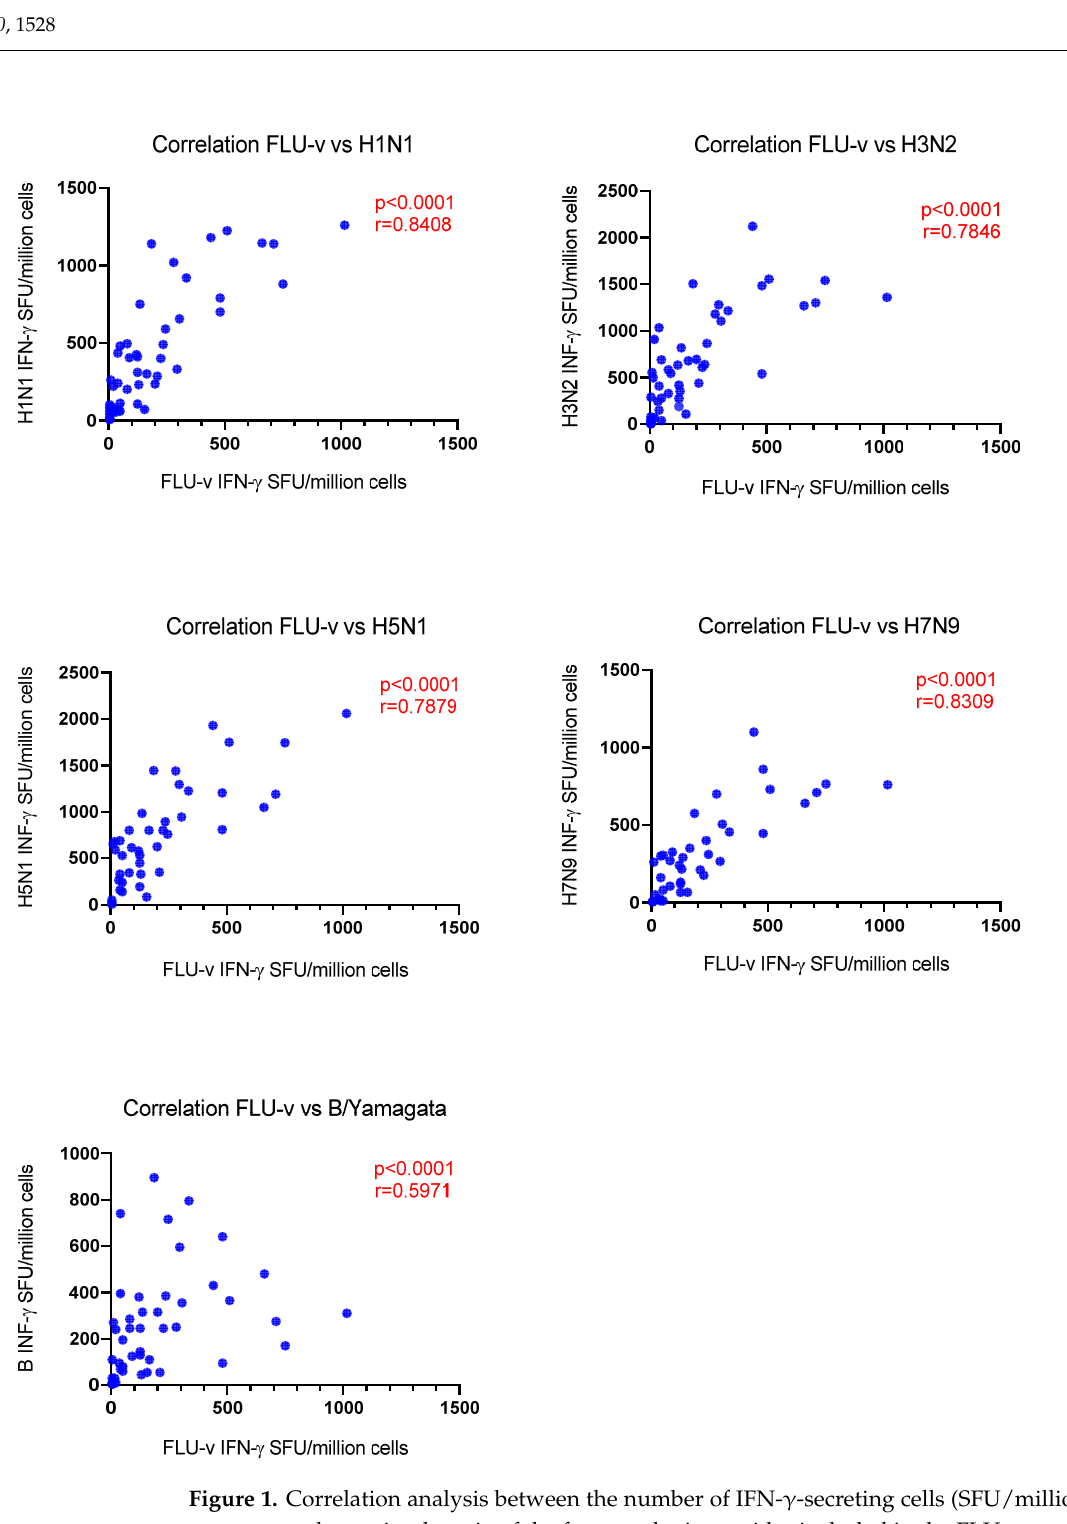
Figure 1. Correlation analysis between the number of IFN- γ -secreting cells (SFU/million cells) in response to the equimolar mix of the four synthetic peptides included in the FLU-v vaccine and in response to whole inactivated influenza strains (A/California/7/2009 (H1N1), A/Shanghai/24/1990 (H3N2), A/Vietnam/1194/2004 (NIBRG-14) (H5N1), A/Anhui/1/2013 (NIBRG-268) (H7N9), and B/Brisbane/9/2014 (Yamagata lineage)) on day 42 in the FLU-v vaccinated group. Correlation coefficients (r) and p -values according to the Spearman analysis are indicated.